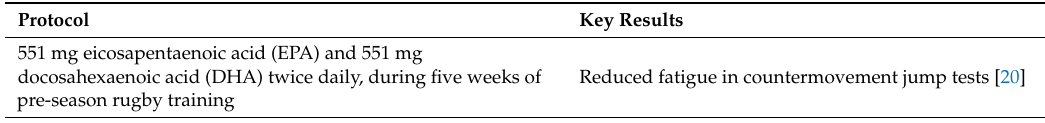
Table 1. Summary of the impact of n -3 PUFAs in